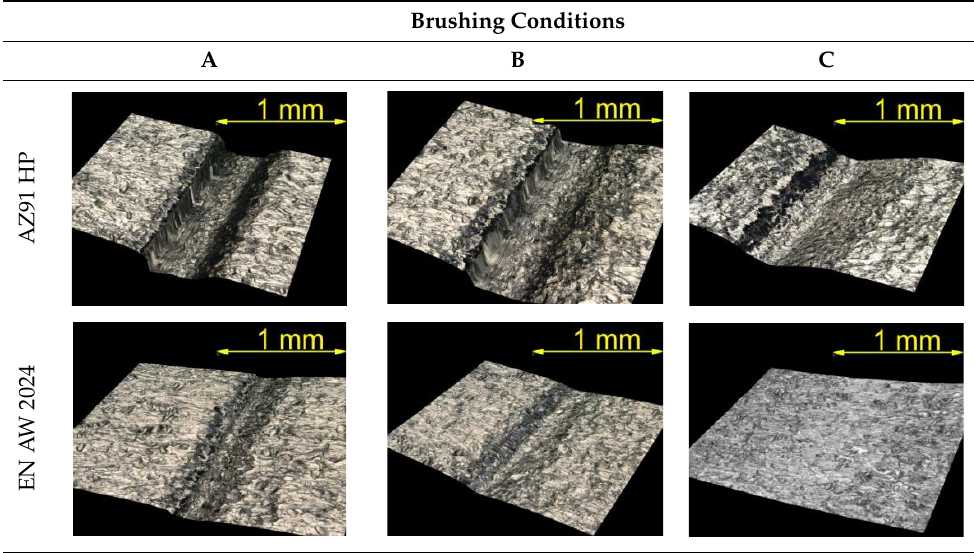
Table 4. View of defects after the brushing process (for a defect generator load of 5 N).